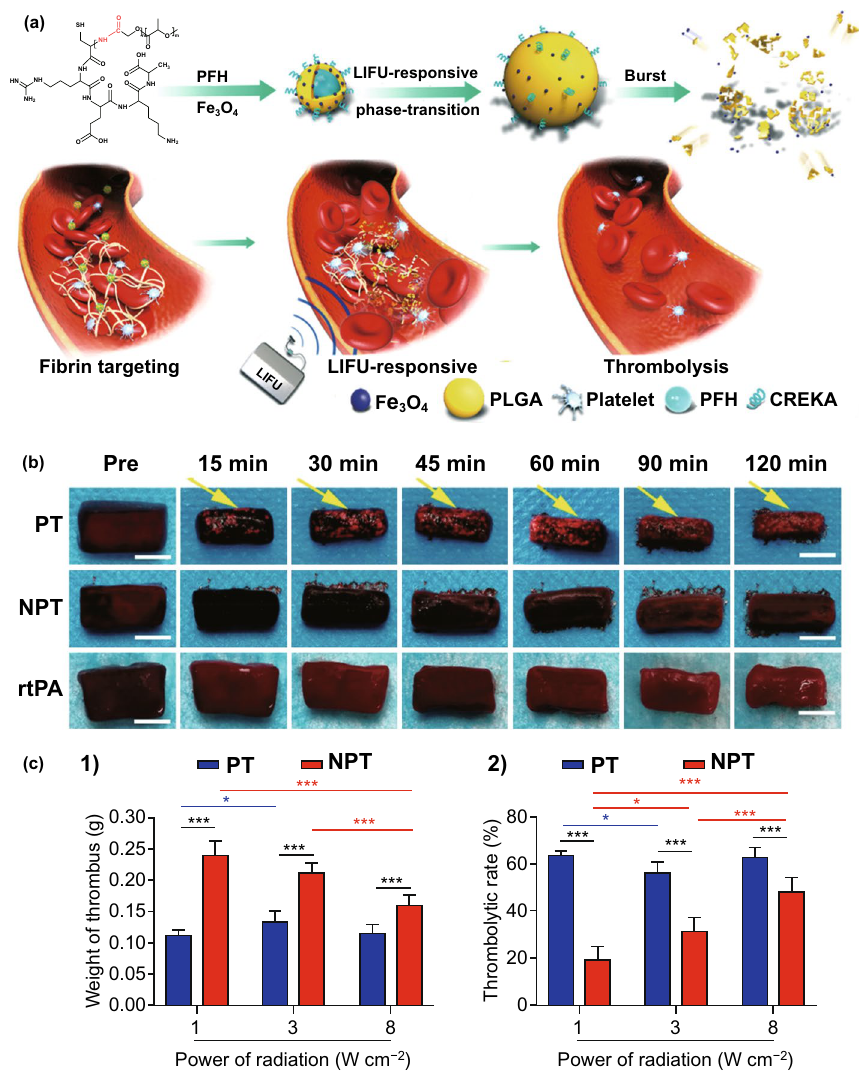
Fig. 7 a Schematic illustration of PLGA-based multifunctional nanoparticles, and the PT thrombolysis process under the LIFU pulses. b The photographs of blood clots treated with PT, NPT, and rtPA at different time points. c The final thrombus weights ( 1 ) and final thrombolytic rates ( 2 ) of PT and NPT under different LIFU pulses power [110]. Copyright 2019 American Chemical